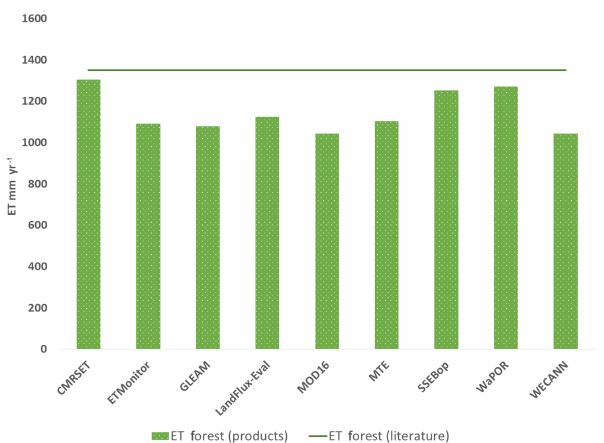
Figure 12. Comparison of the mean ET across water bodies esti- mated by each ET product and PET using the average of three PET